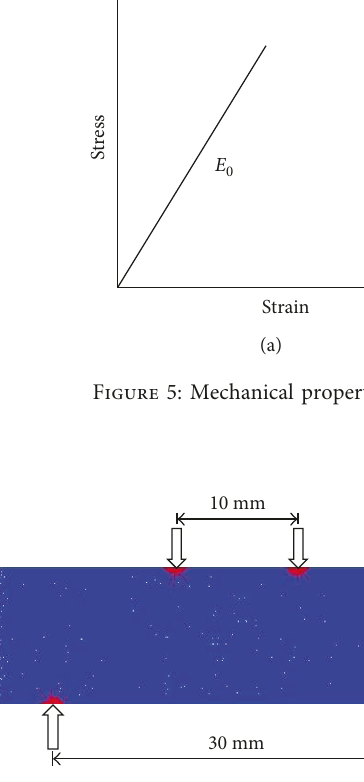
Figure 6: Four-point bending test setup for the UHPFRC